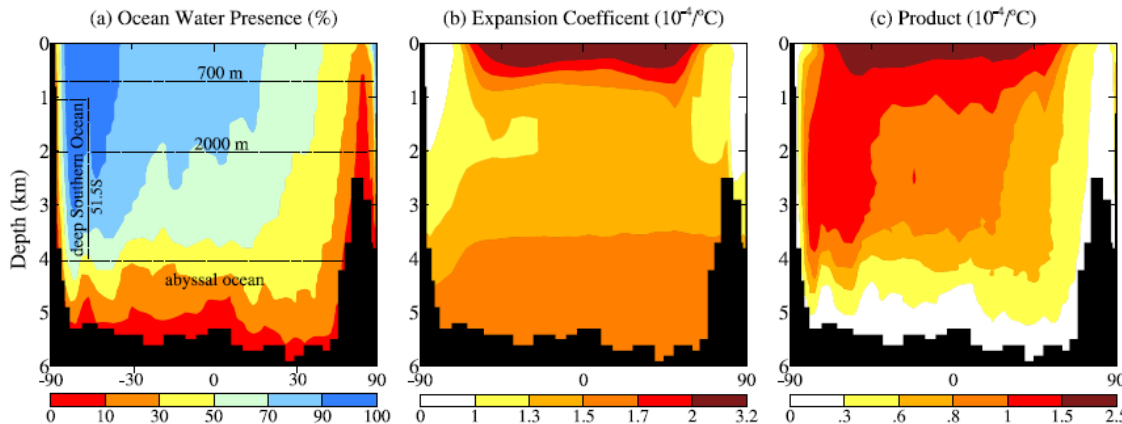
Fig. 13. (a) Percent of latitude-depth space occupied by water, (b) thermal expansion coefficient of water in today’s ocean, (c) product of the quantities in (a) and (b). Equal intervals of the latitude scale have equal surface area. Calculations are area-weighted. Latitude ranges 90–60 ◦ S, 60–30 ◦ S, 30 ◦ S–0, 0–30 ◦ N, 30–60 ◦ N, 60–90 ◦ N contain 5, 26, 28, 27, 12, 2 percent of the ocean mass, and ocean surface in these latitude belts cover 4, 17, 19, 18, 9, 3 percent of the global surface area, respectively.